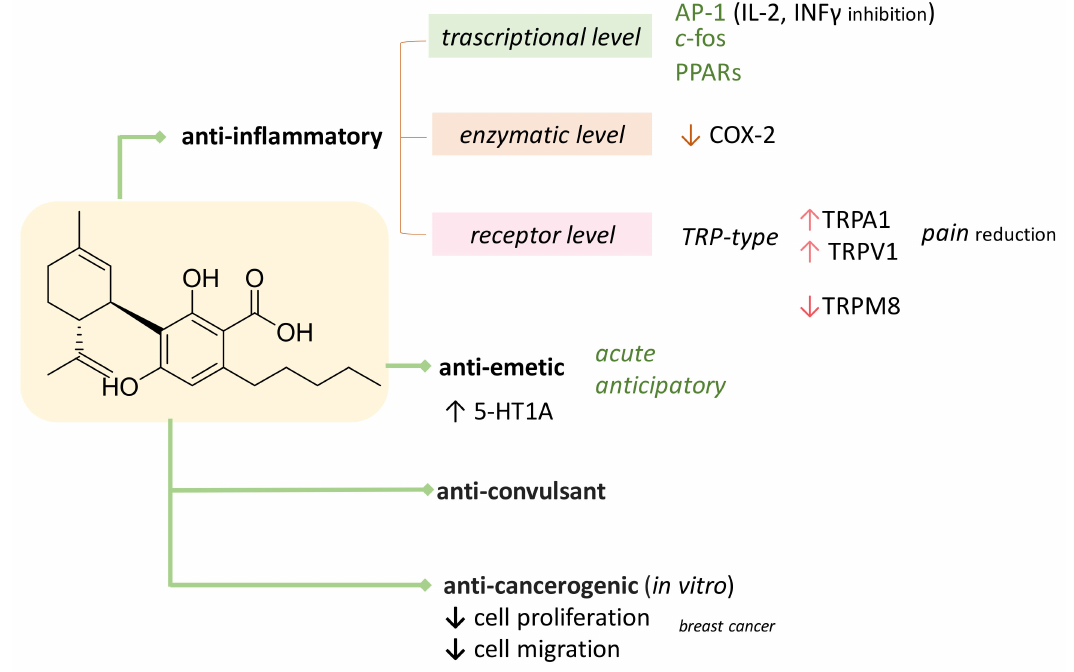
Figure 3. Overview of actual knowledge on CBDA bioactivity. COX-2, cyclooxygenase-2; TRPV1, vanilloid 1 transient receptor potential; TRPA1, ankyrin 1 TRP; AP-1, activator protein